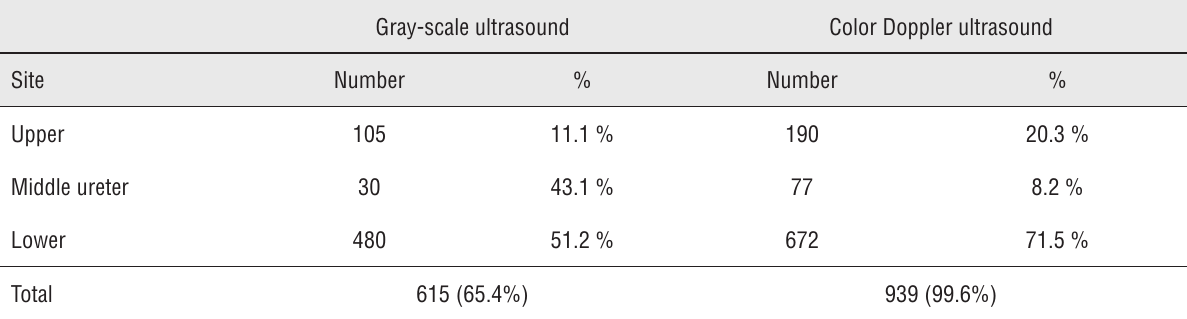
Table 1 - Detection rate and distribution of ureteral stones in 935 cases (bilateral in 4 cases) after comparison between gray scale ultrasound and color Doppler ultrasound.